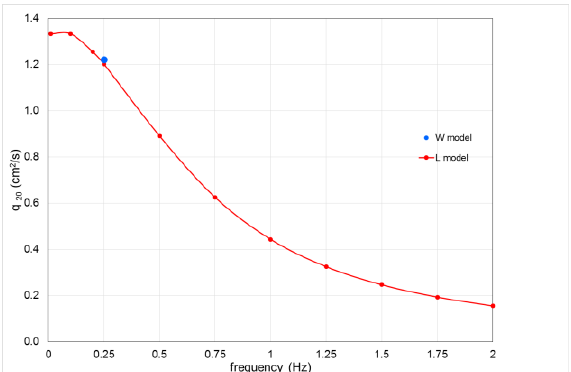
Figure 5. Second-order steady velocity: frequency of disturbance 0.25 Hz, ε = 0.25 for L and W models.